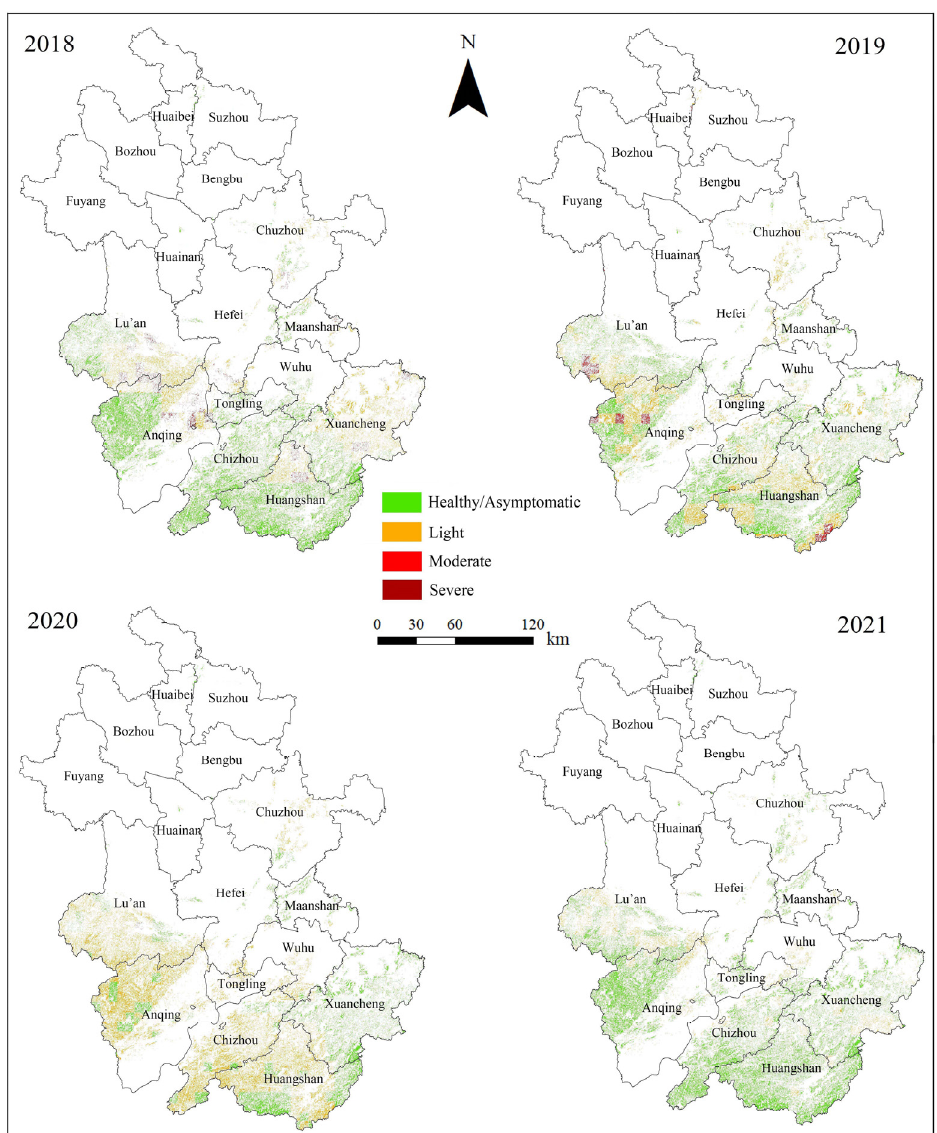
Figure 8. Grading map of PWD degree from 2018 to